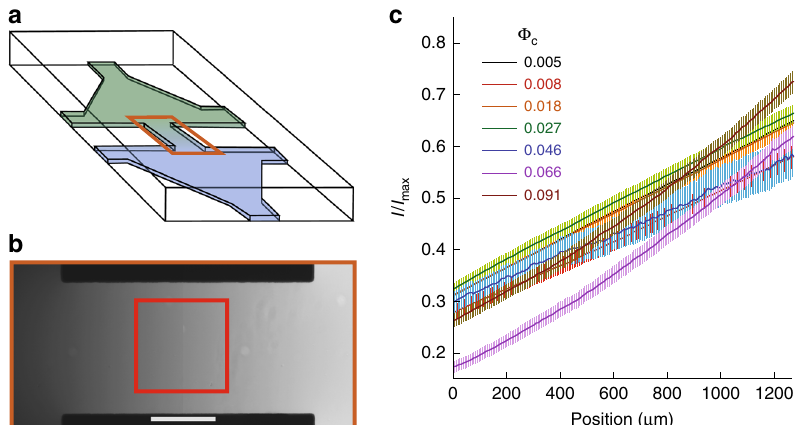
Fig. 1 Micro fl uidic device used for chemotaxis assays. a Schematic representation of the device, where two reservoirs with different chemical composition are connected by a channel in which the chemoattractant gradient forms. b Central part of the device, highlighted orange in ( a ), with gradient pro fi le across the channel quanti fi ed using fl uorescein. Scale bar is 500 μ m. The red box indicates the location at which cellular behaviour is recorded. c Examples of gradients, measured in the h ¼ 50 μ m device, for cell suspensions of indicated cell densities. Error bars represent